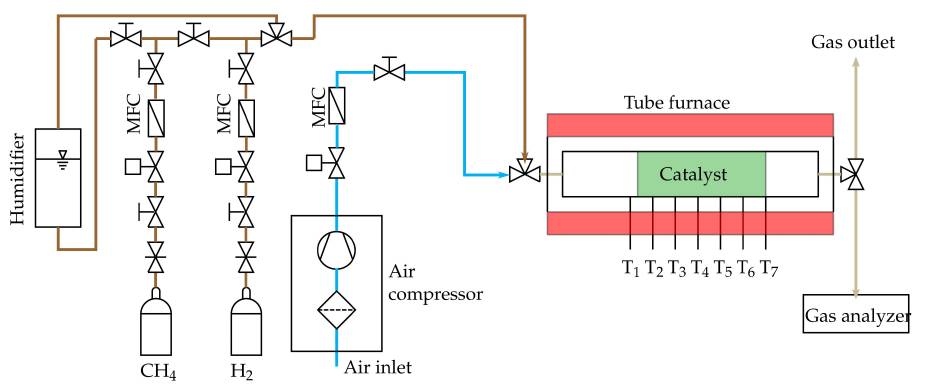
Figure 5. Scheme of the reformer test